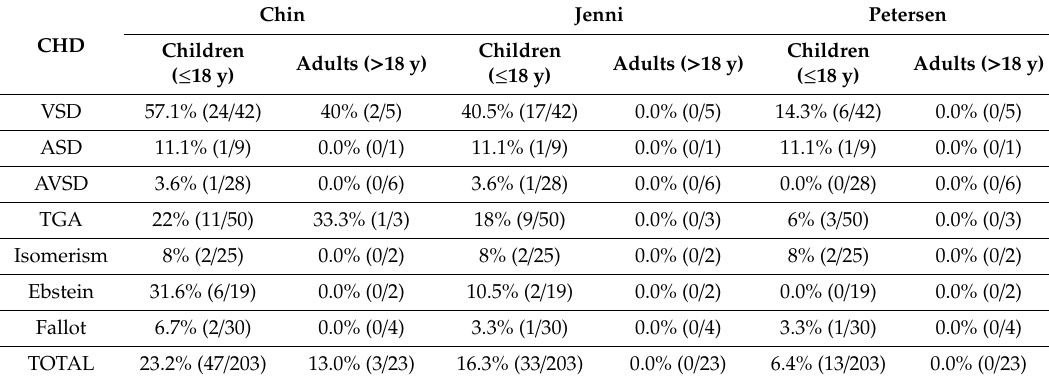
Table 8. Percentage of hearts presenting LVNC according to Chin, Jenni, and Petersen when stratified by age in years (y) at the